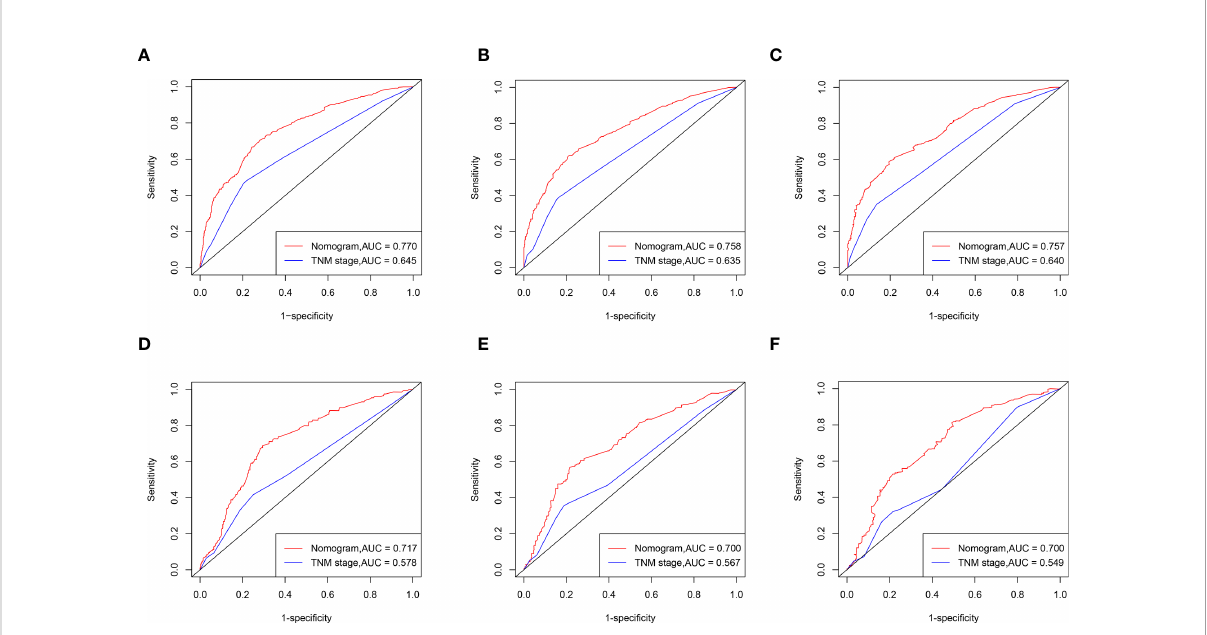
FIGURE 5 ROC curves of the nomogram for CSS compared with TNM staging. ROC curves comparation of the nomogram and TNM staging for 1-year (A) , 3-year (B) and 5-year (C) CSS in the training set. ROC curves comparation of the nomogram and TNM staging for 1-year (D) , 3-year (E) and 5- year (F) CSS in the validation set. AUC: area under the curve; ROC, receiver operating characteristic; CSS cancer speci fi c